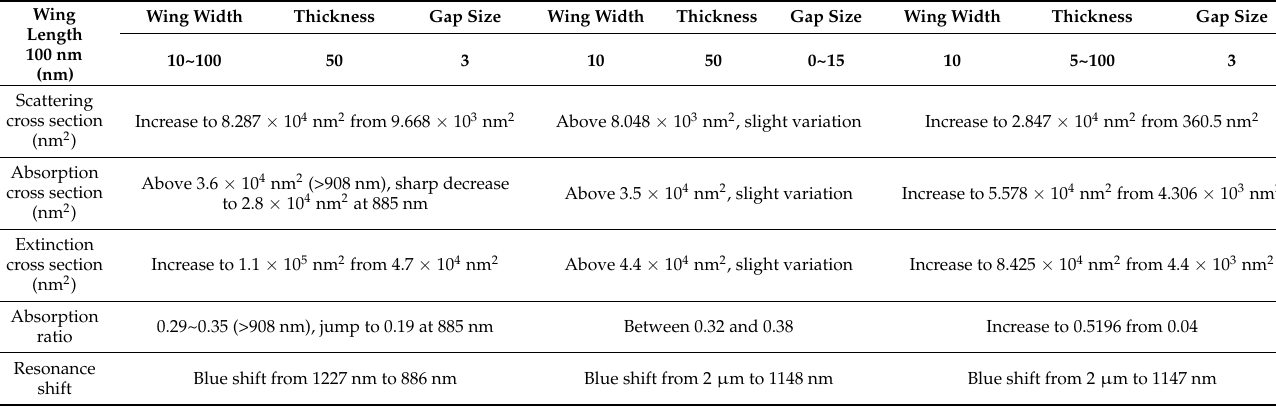
Figure 6. The scattering cross section, absorption cross section, scattering ratio, absorption ratio, average enhancement factor over the simulation object, and average enhancement factor over the